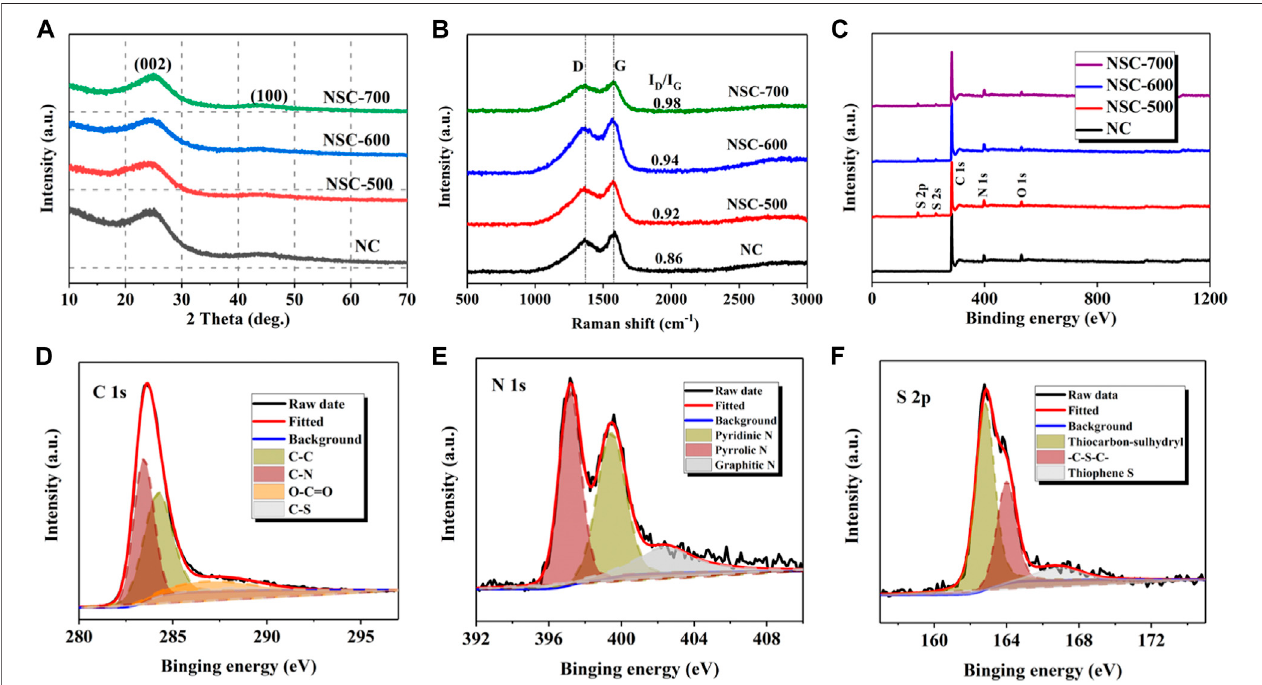
FIGURE 2 | XRD patterns (A , B) Raman spectra and XPS spectra (C) of NC, NSC-500, NSC-600, and NSC-700. High-resolution C 1s (D) , N 1s (E) , and S 2p (F) spectra of NSC-600.